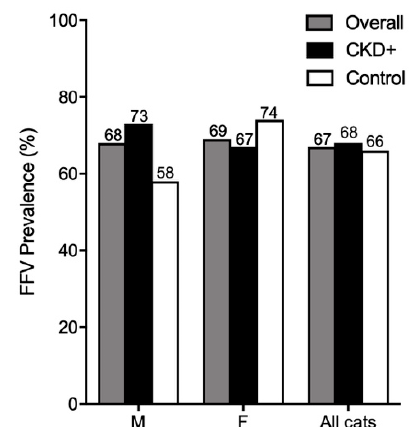
Figure 7. FFV prevalence is high in Australian domestic pet cats. Males with CKD had higher FFV prevalence than male control cats, although not significantly. M = male; F = female.